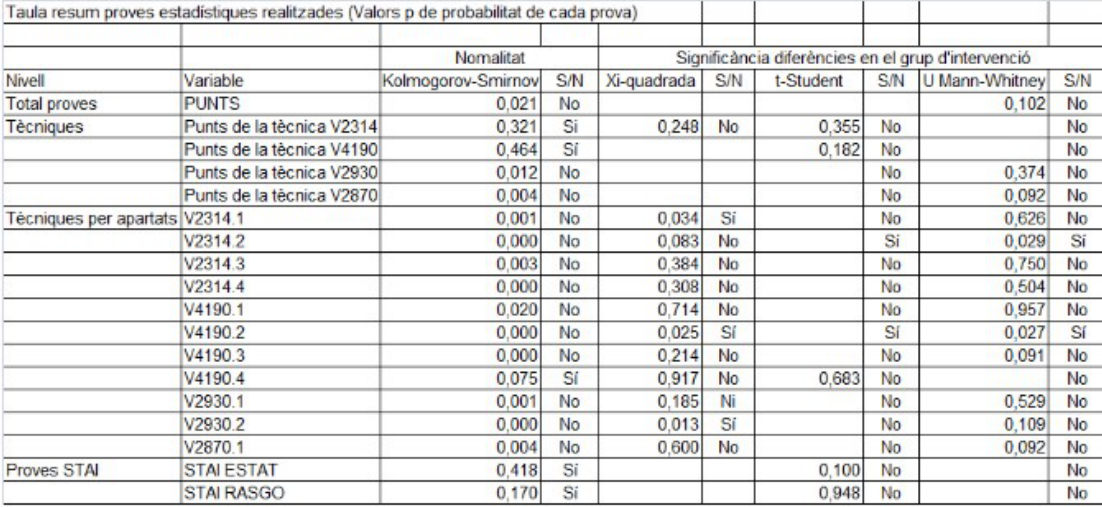
Table 4. Summary table of statstcal tests performed (probability values for each